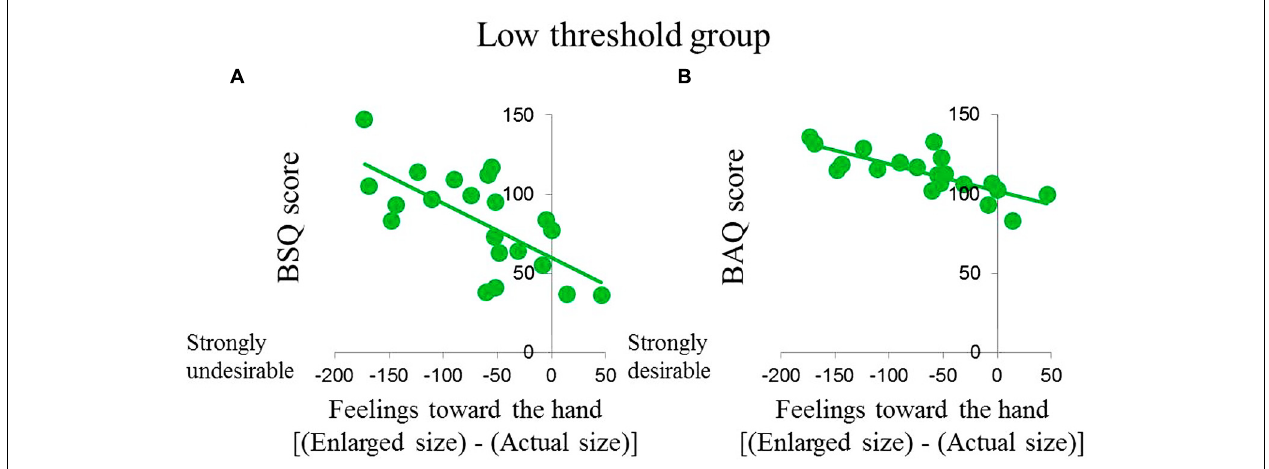
FIGURE 3 | Correlations among (A) BSQ score, (B) BAQ score, and change in feelings toward the hand in the low threshold group. Data indicate significant correlations among parameters ( p < 0.01).